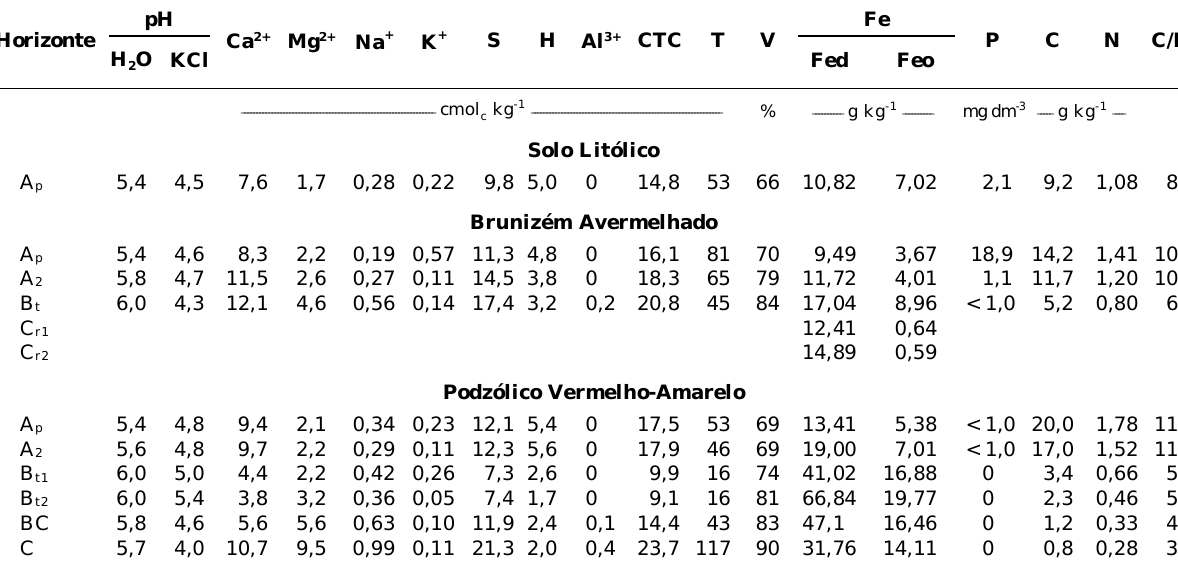
CDNa = citrato-ditionito de